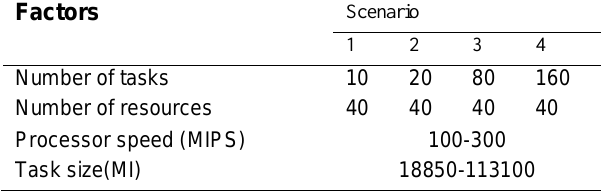
Figure 3. Comparison of existing & proposed system w.r.t BoT Completion Time